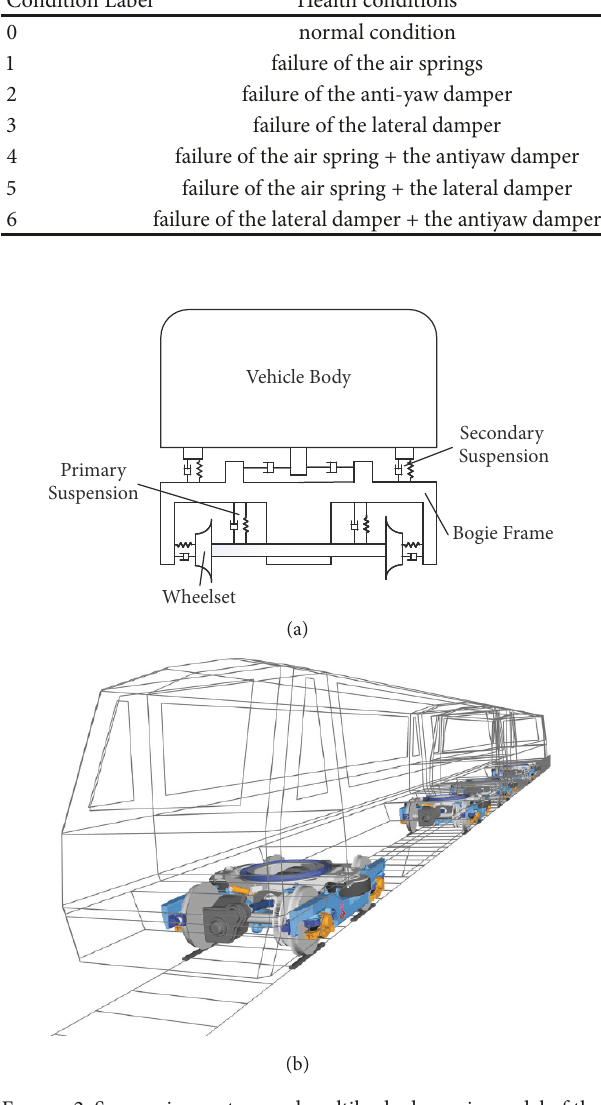
Figure 2: Suspension system and multibody dynamic model of the HST. (a) Suspension system and (b) multibody dynamic